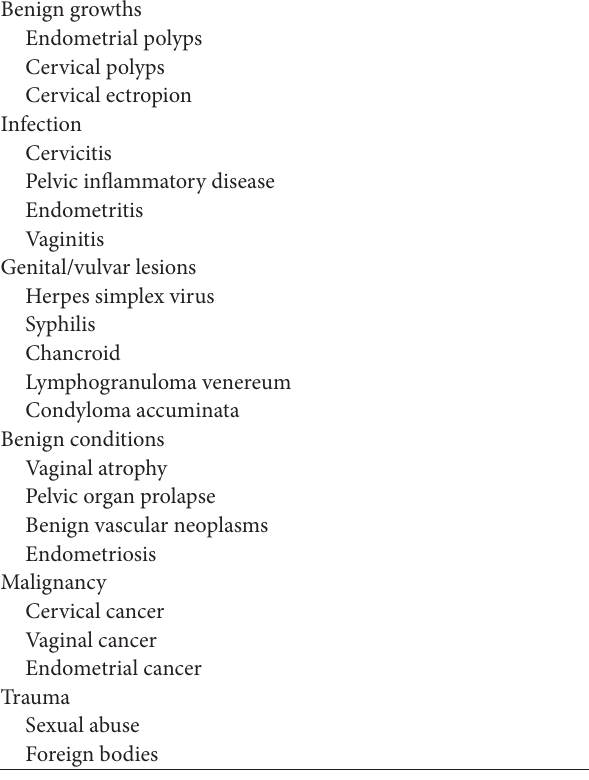
Table 1: Common causes of postcoital bleeding.